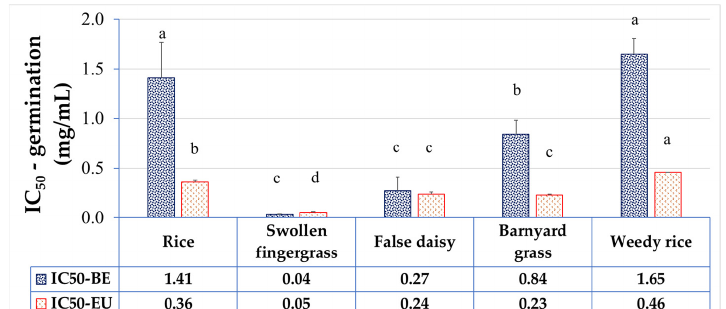
Figure 4. IC 50 values of BE and EU on seed germination by means of paper-plate assay. Values are means ± SD of three replications ( n > 100). Different superscript letters on the bars indicated statistically significant differences of IC 50 among plant species at p < 0.05.